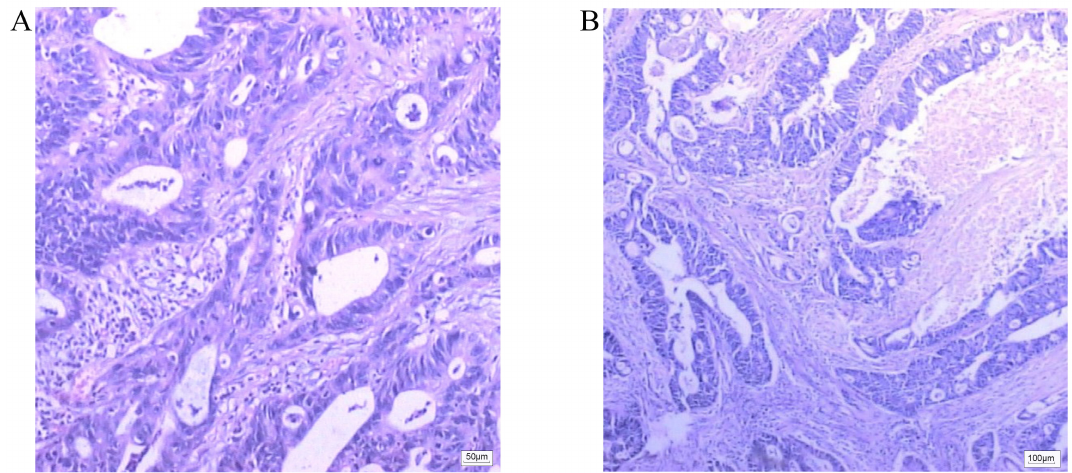
Fig. 1. Histopathological results. (A) Pathological analysis of the primary colon tumor showed a low to moderately differentiated adenocarcinoma that infiltrated the whole colon wall, along with 4 lymphatic metastases (hematoxylin and eosin stain, original magnifi- cation 400 × ). (B) Transurethral cystoscopy biopsy showed nests of acinar-like cells with cytological atypia, consistent with metastatic